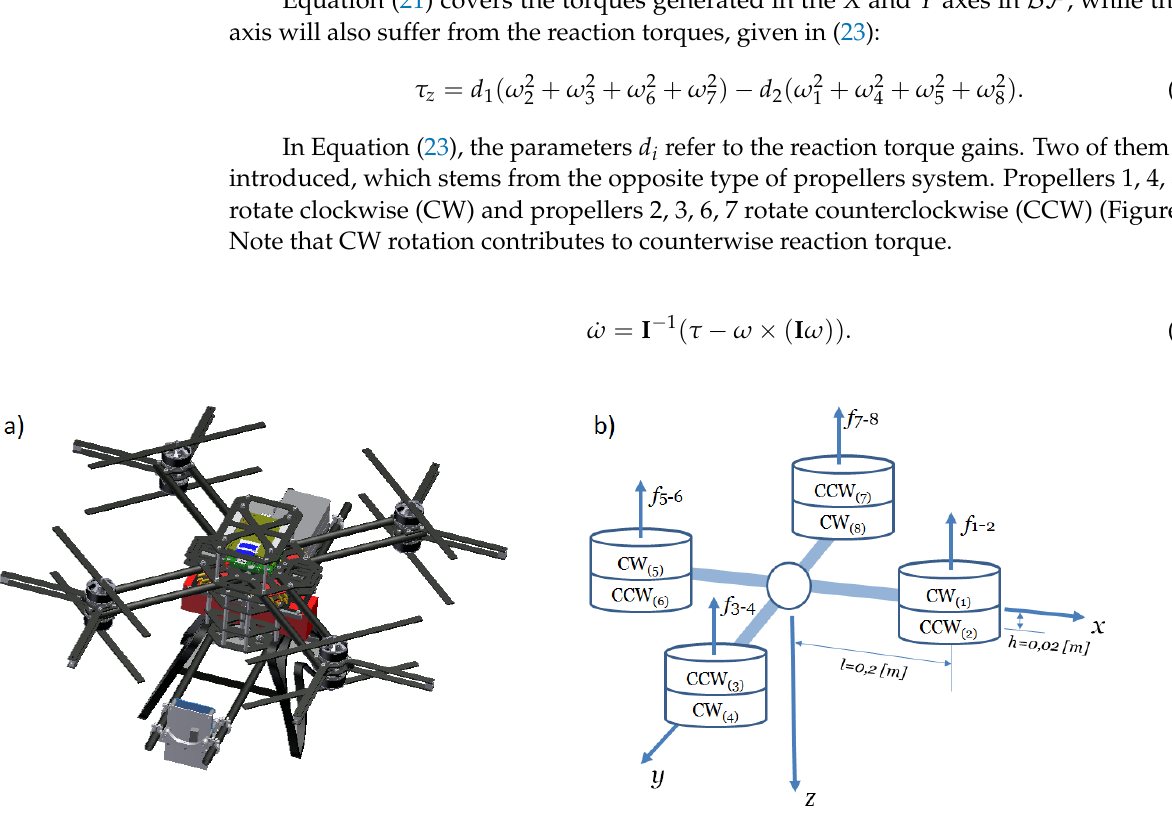
Figure 6. Falcon V5 ( a ) 3D model, ( b ) scheme ( ω :